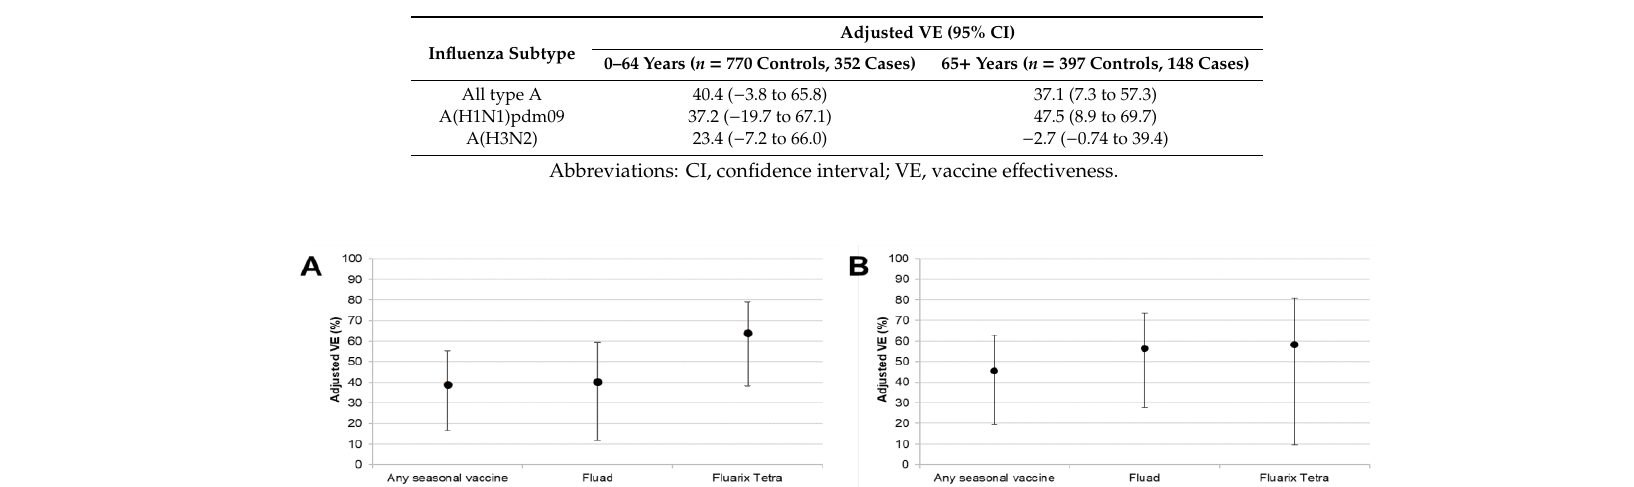
Table 4. Adjusted estimates of VE, overall and stratified by age group.